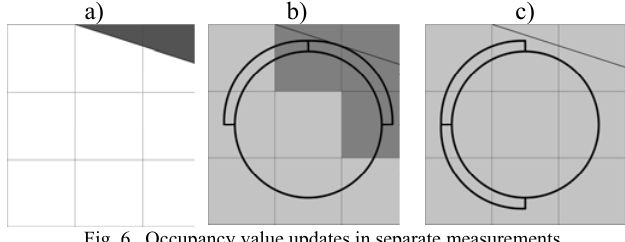
Fig. 6. Occupancy value updates in separate